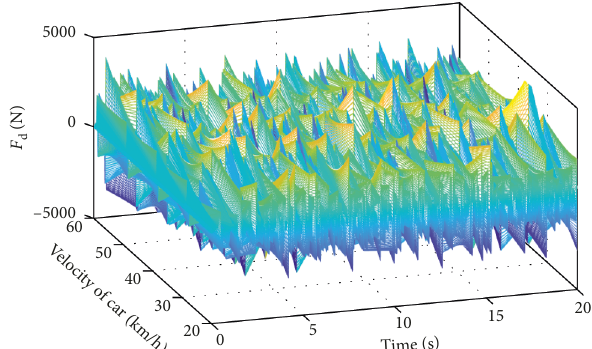
Figure 2: The variation of the dynamic wheel load with the var- iation of the car velocity for the specific road profile.